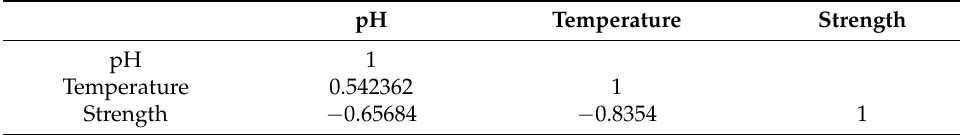
Table 8. Correlation analysis results (pH = 7.0).